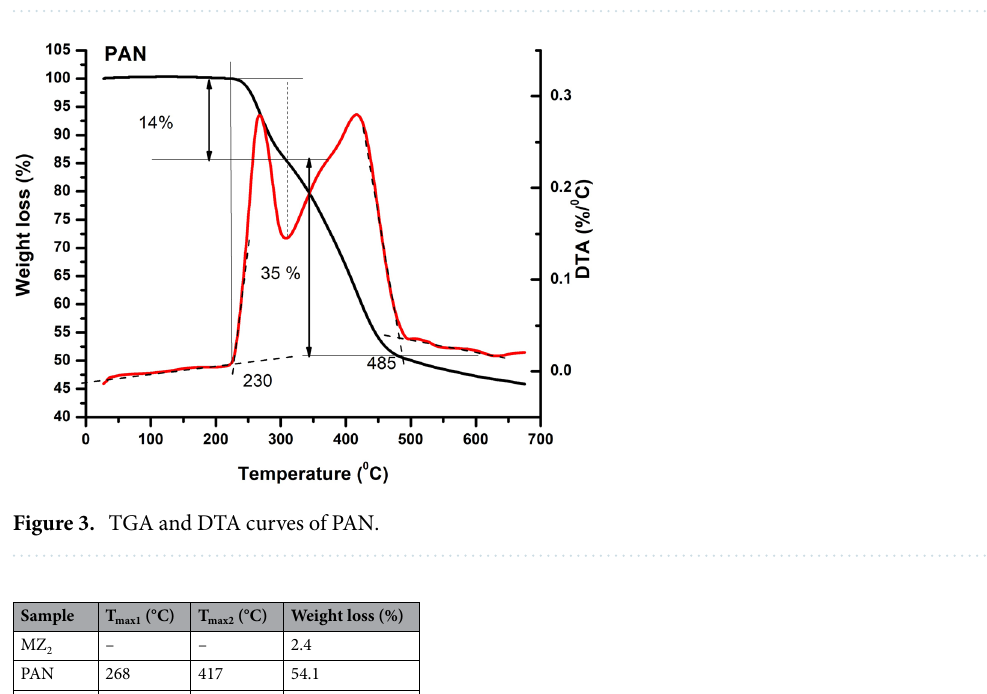
Figure 2. ( a ) TGA curves and ( b ) DTA curves of MZ 2 , PAN, 30MZ 2 and 50MZ 2 .